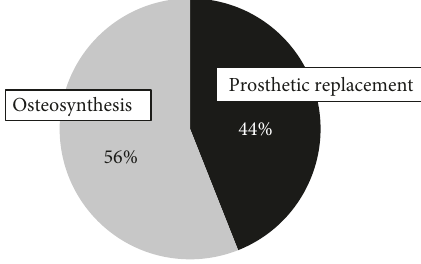
Figure3:Of1,042patientswithfractureoftheproximalfemur,Type 1-2-3(-4)fracturesaccountfor 1.72%,with osteosynthesis performed for 56% and prosthetic replacement performed for